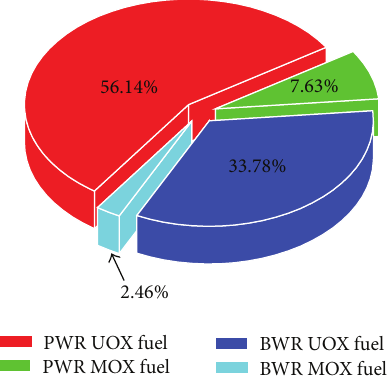
F 3: Breakdown by fuel type of accumulated spent fuel mass in